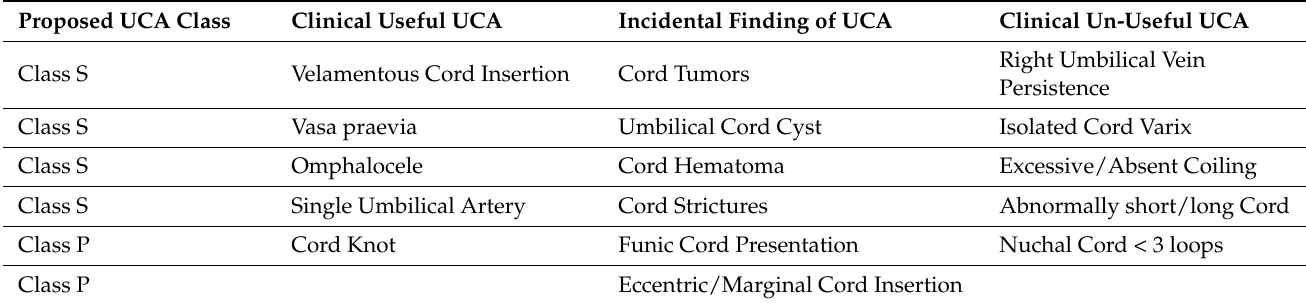
Table 2. Proposed classification of the Umbilical Cord Anomalies.